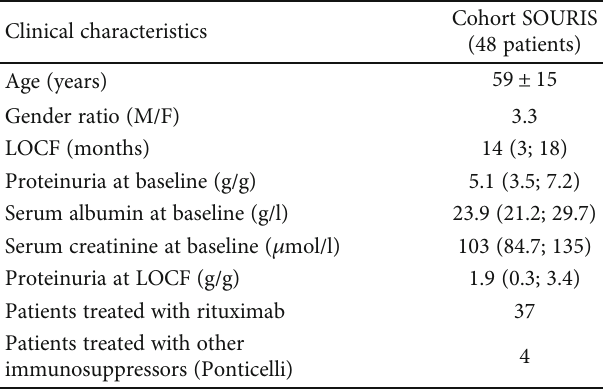
Table 1: Clinical characteristics of patients in the study. Clinical